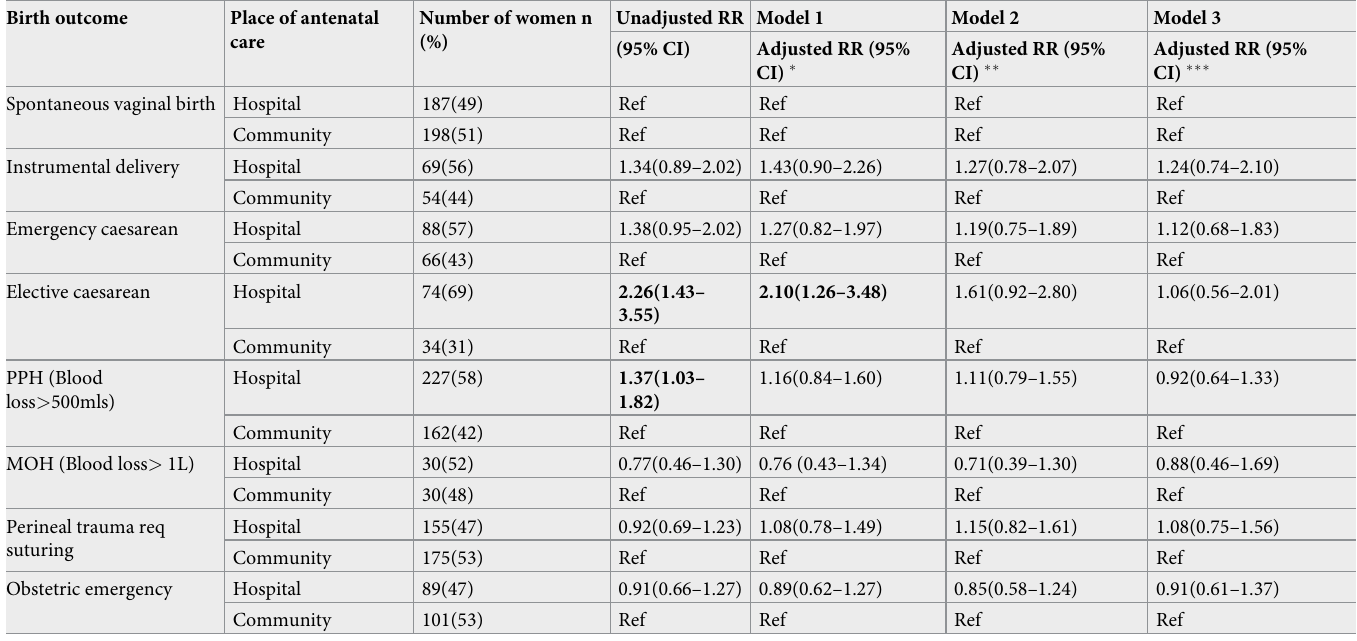
Table 5. Maternal birth outcomes in relation to the place of antenatal care.